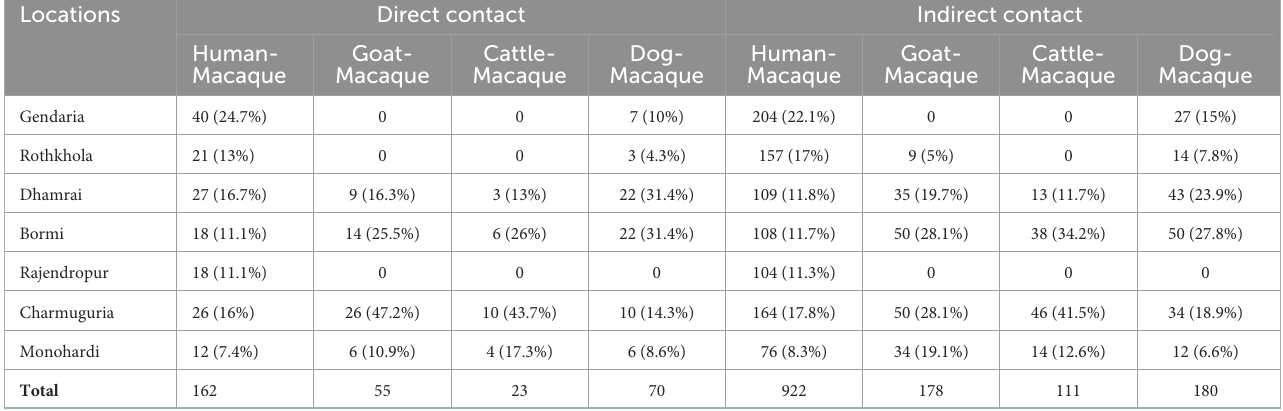
TABLE 6 Direct and indirect interactions between macaques and other species (8h). Locations